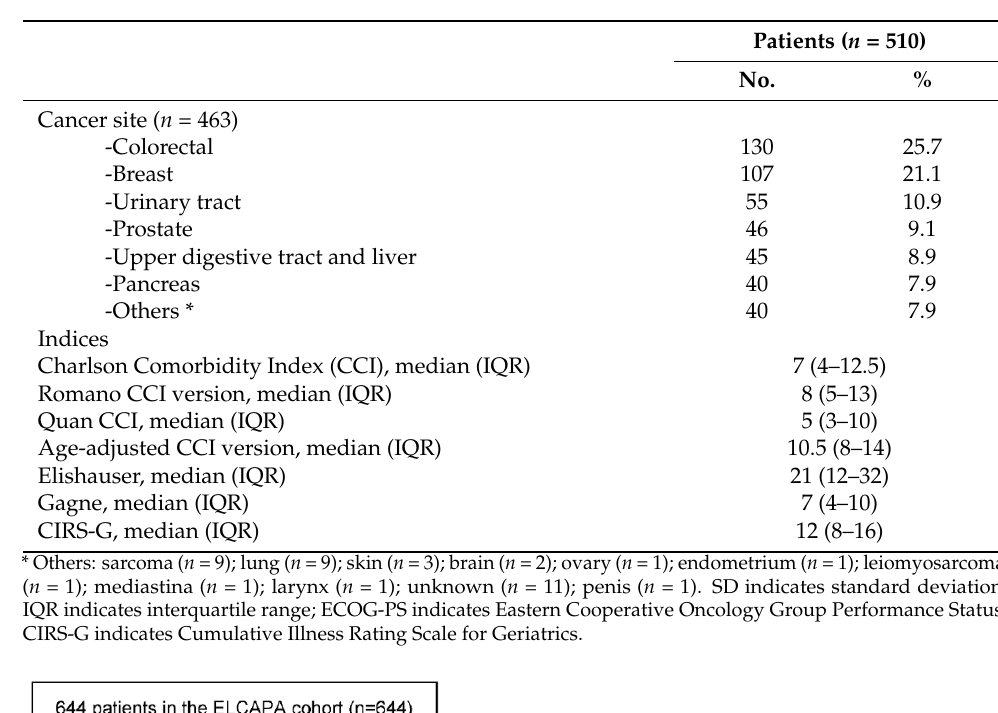
Table 1. Main characteristics of the 510 patients included.